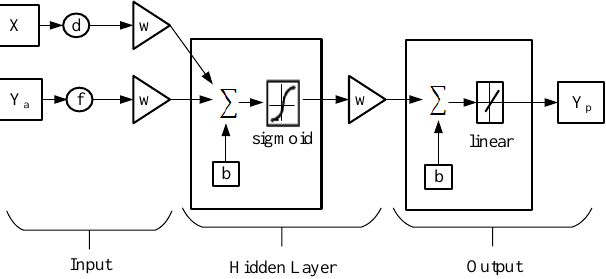
Figure 1. Structure of the series-parallel nonlinear auto-regressive with exogenous input (NARX) network “open-loop”. Y a and Y b represent the dataset of an event to be forecasted (i.e., wind speed) and the predicted value, respectively. The input and feedback delays are d and f, respectively. The input X represents the exogenous inputs to the model (e.g., temperature, pressure, etc.).